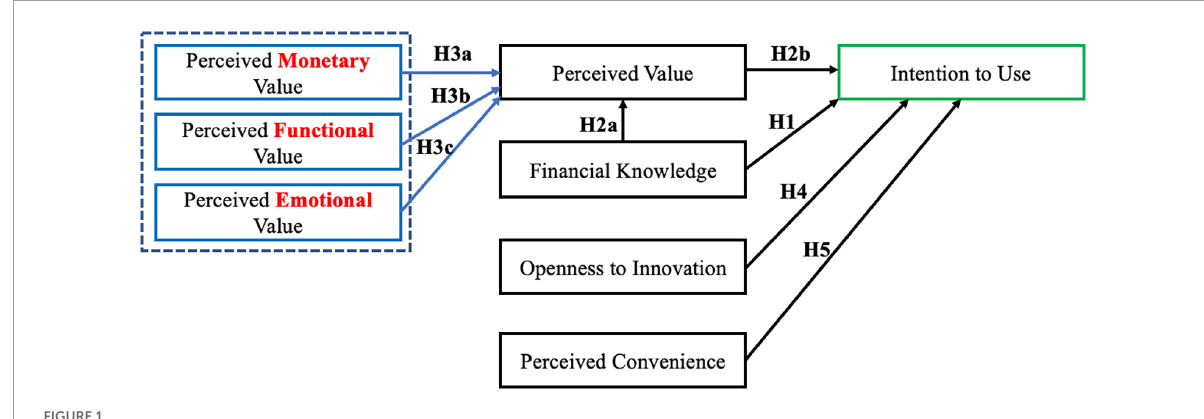
FIGURE1 The hypothesized conceptual